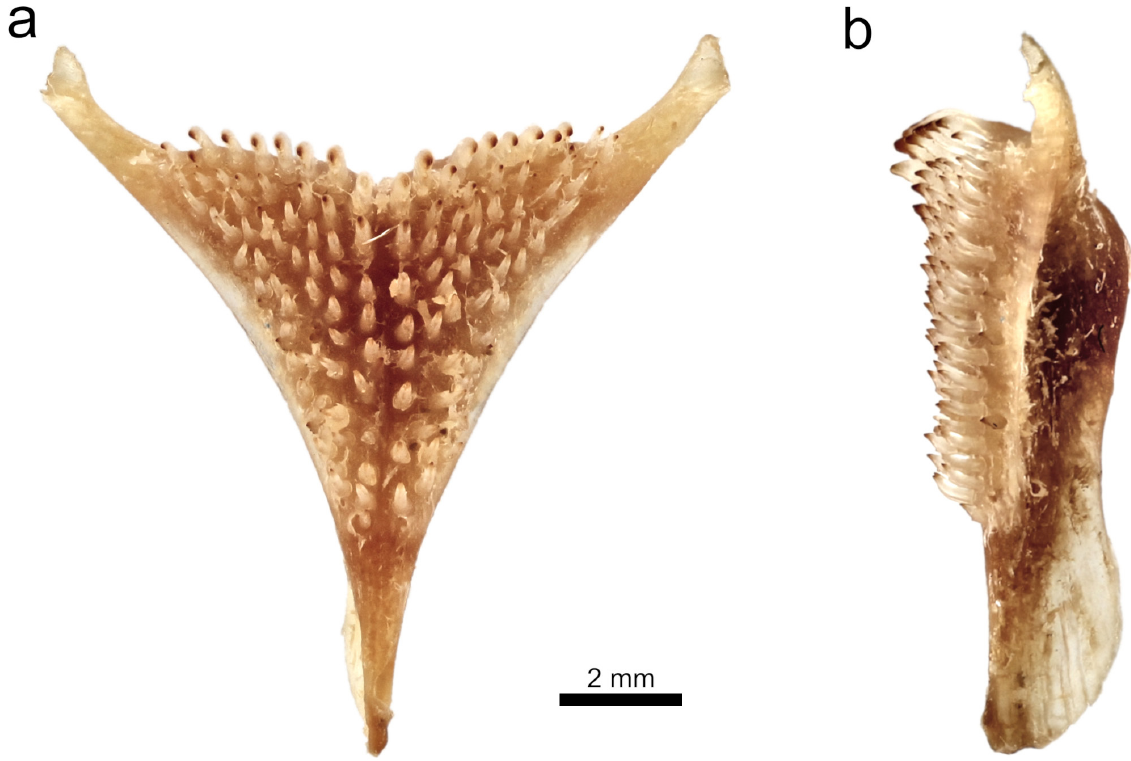
Fig. 28. Haplochromis falcatus sp. nov. (RMCA 2018.008.P.0397; 103.3 mm SL). a . Dorsal view of the lower pharyngeal jaw. b . Lateral view of the lower pharyngeal